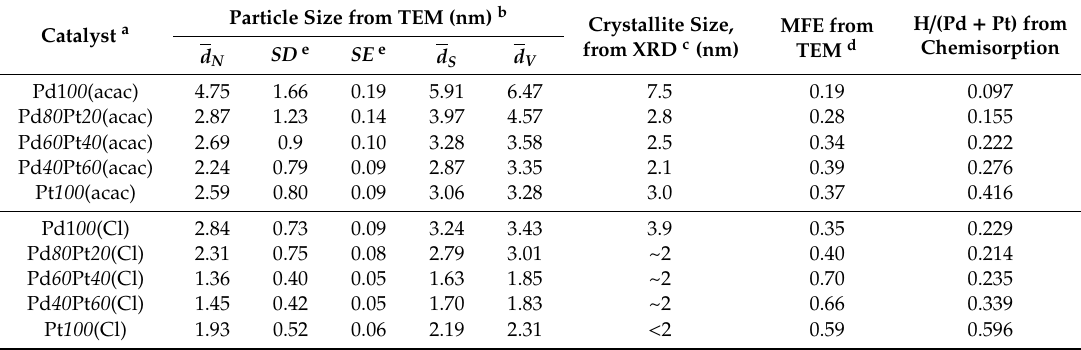
Table 1. Metal particle size (from TEM), crystallite size from XRD, and metal dispersion in two series of carbon-supported Pd–Pt catalysts subjected to reduction in H 2 / Ar at 400 ◦ C. Particle Size from TEM (nm) Catalyst a